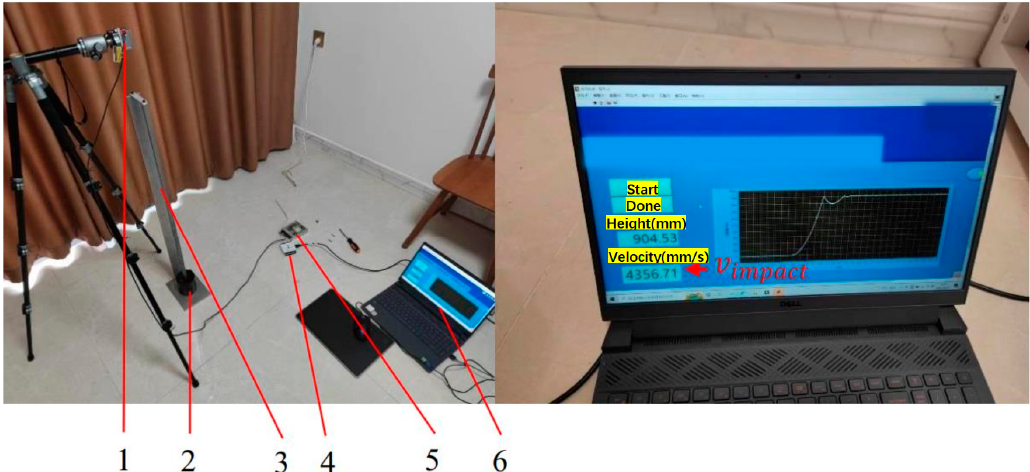
Figure 7. Actual experiment device. 1. Laser displacement sensor; 2. Falling weight; 3. Guide rail; 4. Data acquisition system (Ni DAQ); 5. Power supply; 6. Computer. Table 3. Parameter values of the actual experiment .